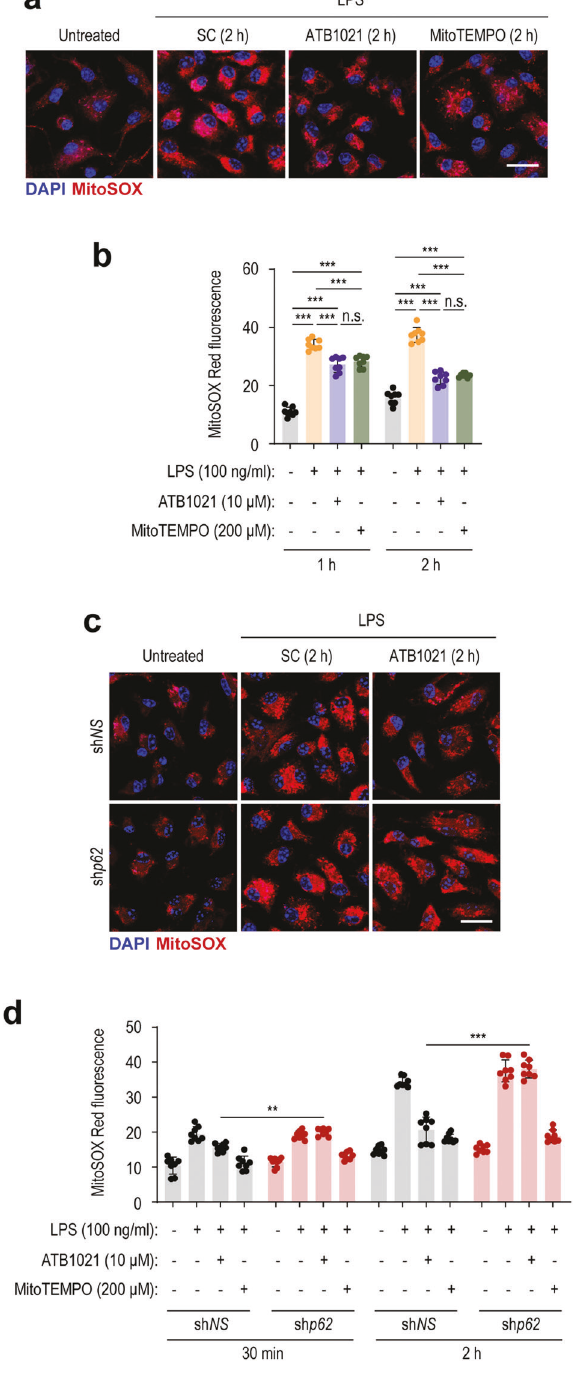
Fig. 7 A p62 ligand inhibits LPS-induced mtROS production in a p62-dependent manner. a , b PMs were pretreated with vehicle, ATB1021 (10 μ M), or MitoTEMPO (200 μ M) and then stimulated with LPS (100 ng/mL) for 1 h or 2 h; next, they were stained with MitoSOX (red) or DAPI (blue). Representative images ( a ) and MitoSOX fl uorescence intensities ( b ). Scale bar, 10 μ m. c , d PMs transduced with sh NS or sh p62 were pretreated with vehicle, ATB1021 (10 μ M), or MitoTEMPO (200 μ M) and then stimulated with LPS (100 ng/mL) for 30 min or 2 h; next, they were stained with MitoSOX (red) or DAPI (blue). Representative images ( c ) and MitoSOX Red fl uorescence intensities ( d ). Scale bar, 10 μ m. Means ± SDs are shown ( b , d ). One- way ANOVA with Tukey ’ s multiple comparison test ( b , d ) was used